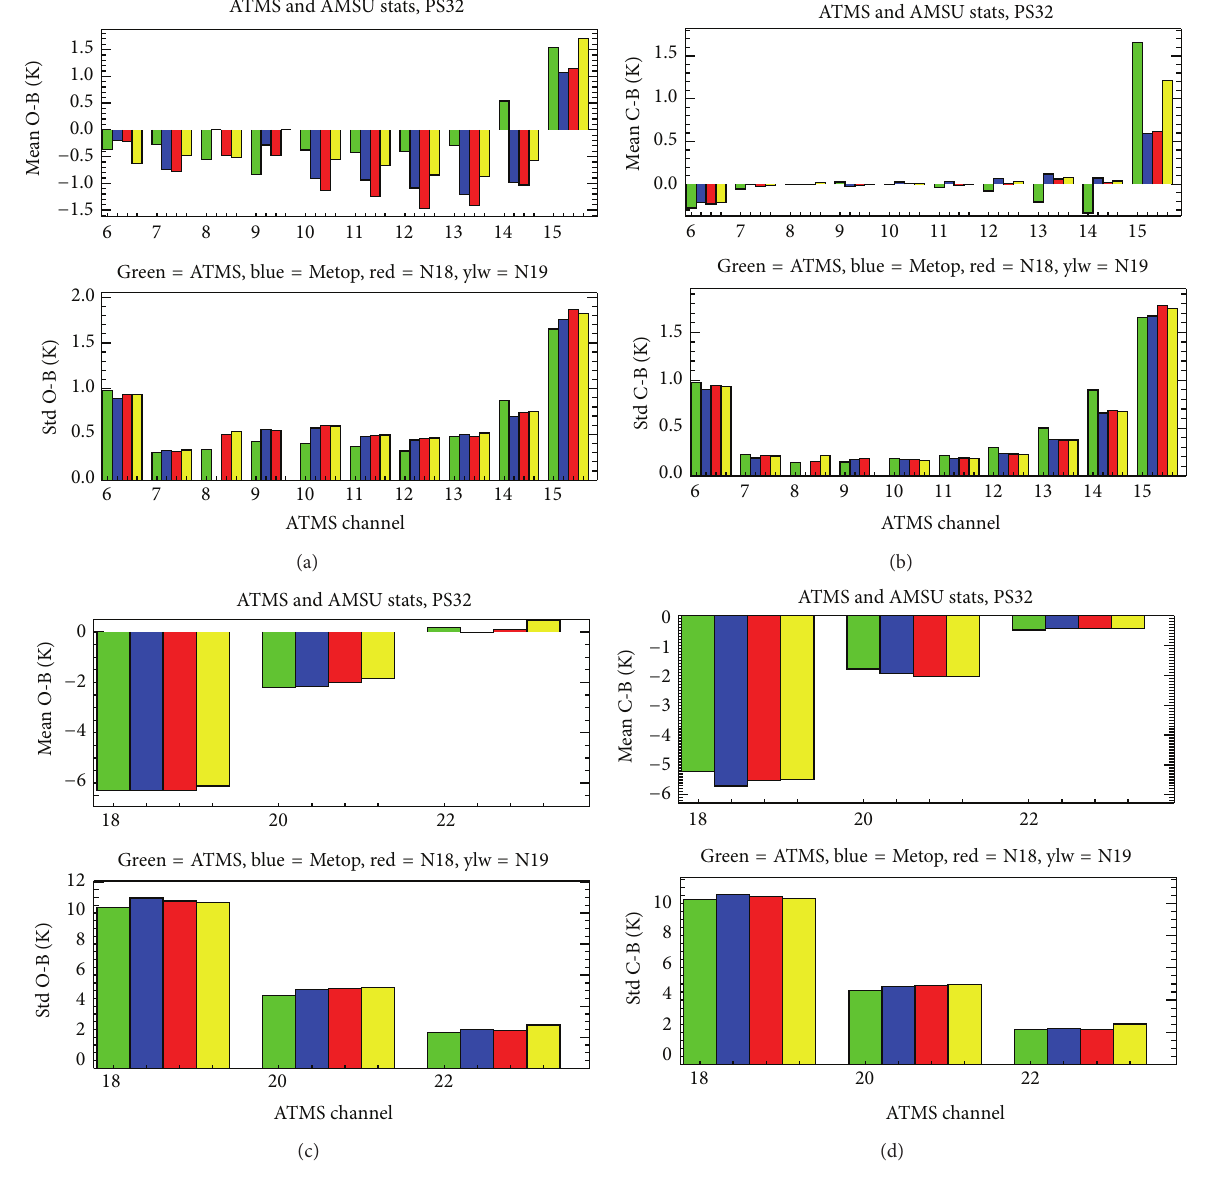
Figure 8: Mean and standard deviation of uncorrected (O-B) and corrected (C-B) innovations for ATMS and AMSU 50–60 GHz temperature sounding channels ((a) and (b)) and 183 GHz humidity sounding channels ((c) and (d)) January to February 2012.